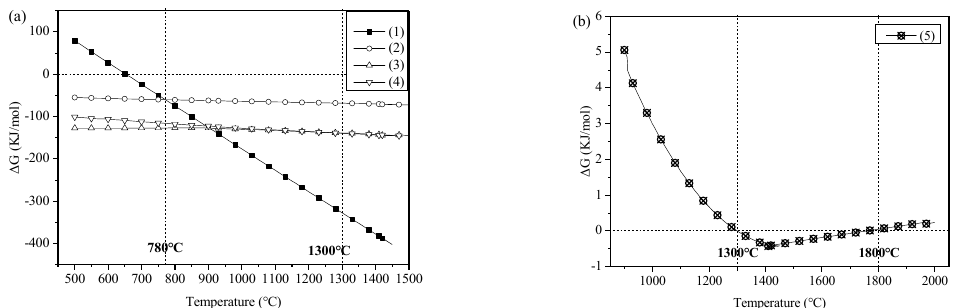
Figure 2. Δ G-T plots for the hematite coupling reactions. ( a ) Equations (1)–(4), ( b ) Equation (5).